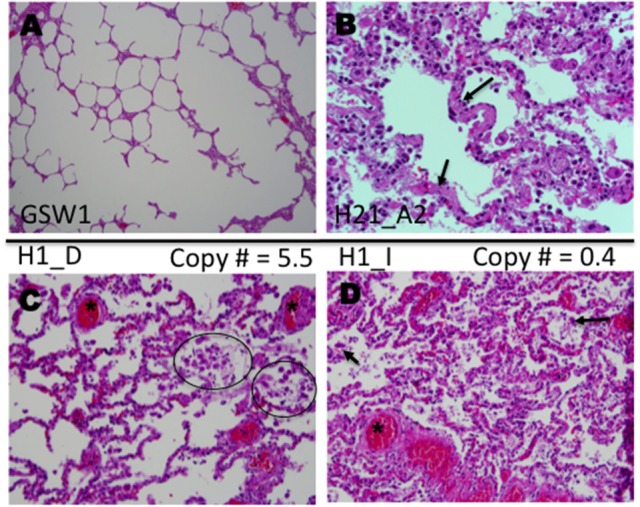
Histological analysis of lung samples of autopsied HPCS cases. Shown are representative sections of lungs stained with Hematoxylin and Eosin (H&E). (A) Sample of lung parenchyma of a gunshot wound decedent, showing open alveolar space (case GSW1). (B) Lung sample of an HCPS patient (case H21 Block A2) highlighting hyaline alveolar membranes (arrows), infiltrates of various immune cells immunoblasts, macrophages and neutrophils (few) (original magnification × 400). (C) Lung sample (case H1 Block D), highlighting focal deposits of macrophages (circles) and intraalveolar extravasated red blood cells (asterisk). (D) Lung sample (H1 case Block I) highlighting extensive congestion and intraalveolar edema with mild interstitial inflammation compared to (case H1 Block D) shown in (C). The values of 5.5 and 0.4 in (C,D) respectively refer to P2Y2R RNA measured in the TaqMan assay (original magnifications for C,D × 200).